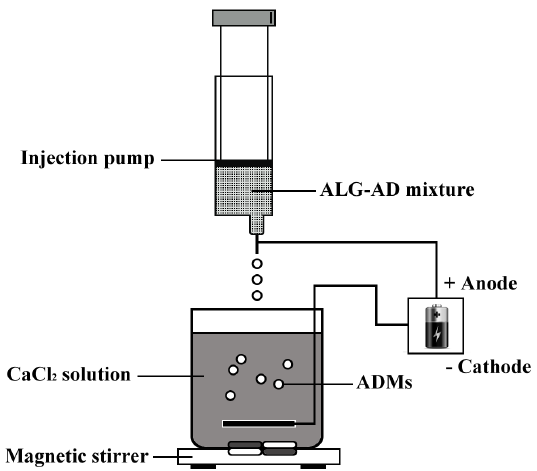
Figure 1. The device used in the microencapsulation process by means of the complex coacervation method. doi:10.1371/journal.pone.0061129.g001 PLOS ONE |